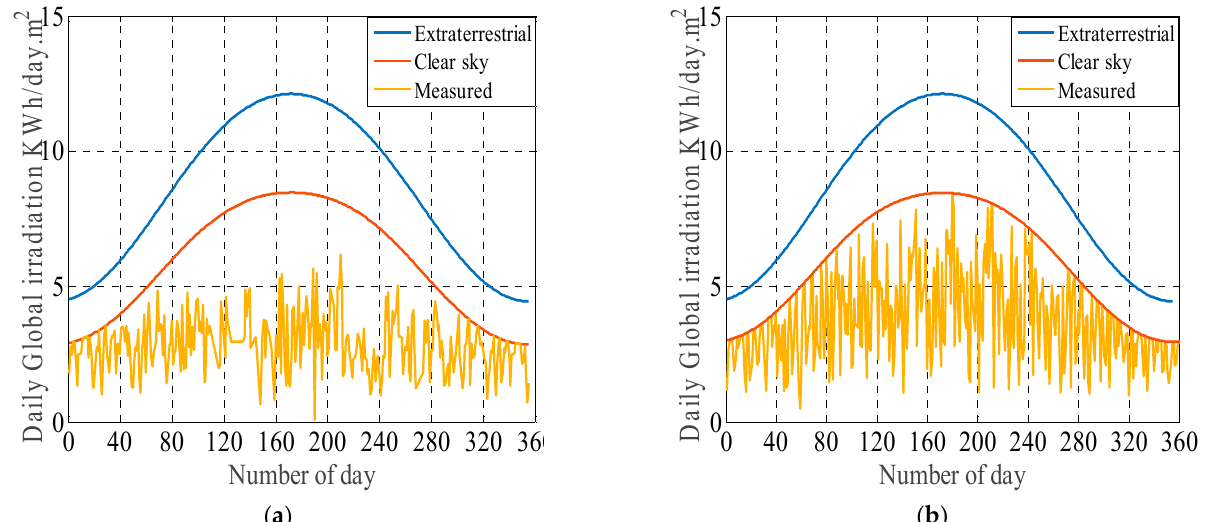
Figure 5. The annual evolution of the daily global solar irradiations on a horizontal plane; the measured (brown), the theoretical (red, and the extraterrestrial (bleu). ( a ) The Tlemcen site; ( b ) the Senia site.